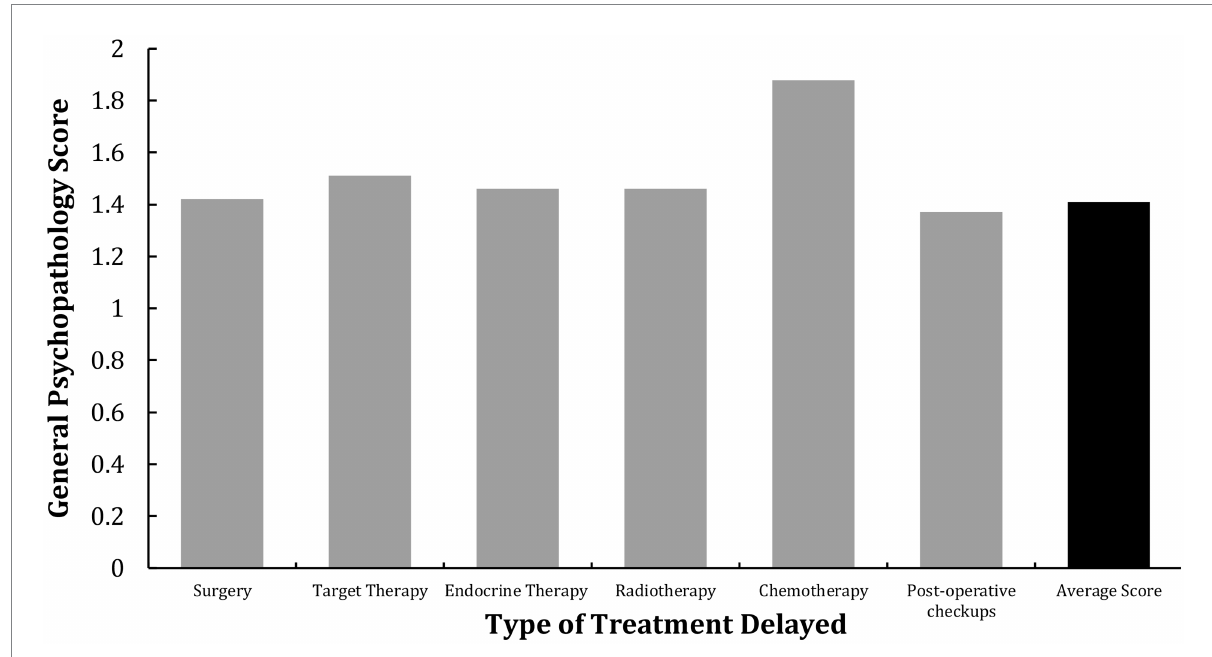
FIGURE 3 The effect of delayed treatment type on general psychopathology score. The delay of chemotherapy had a significant effect on breast cancer patients’ general psychopathology